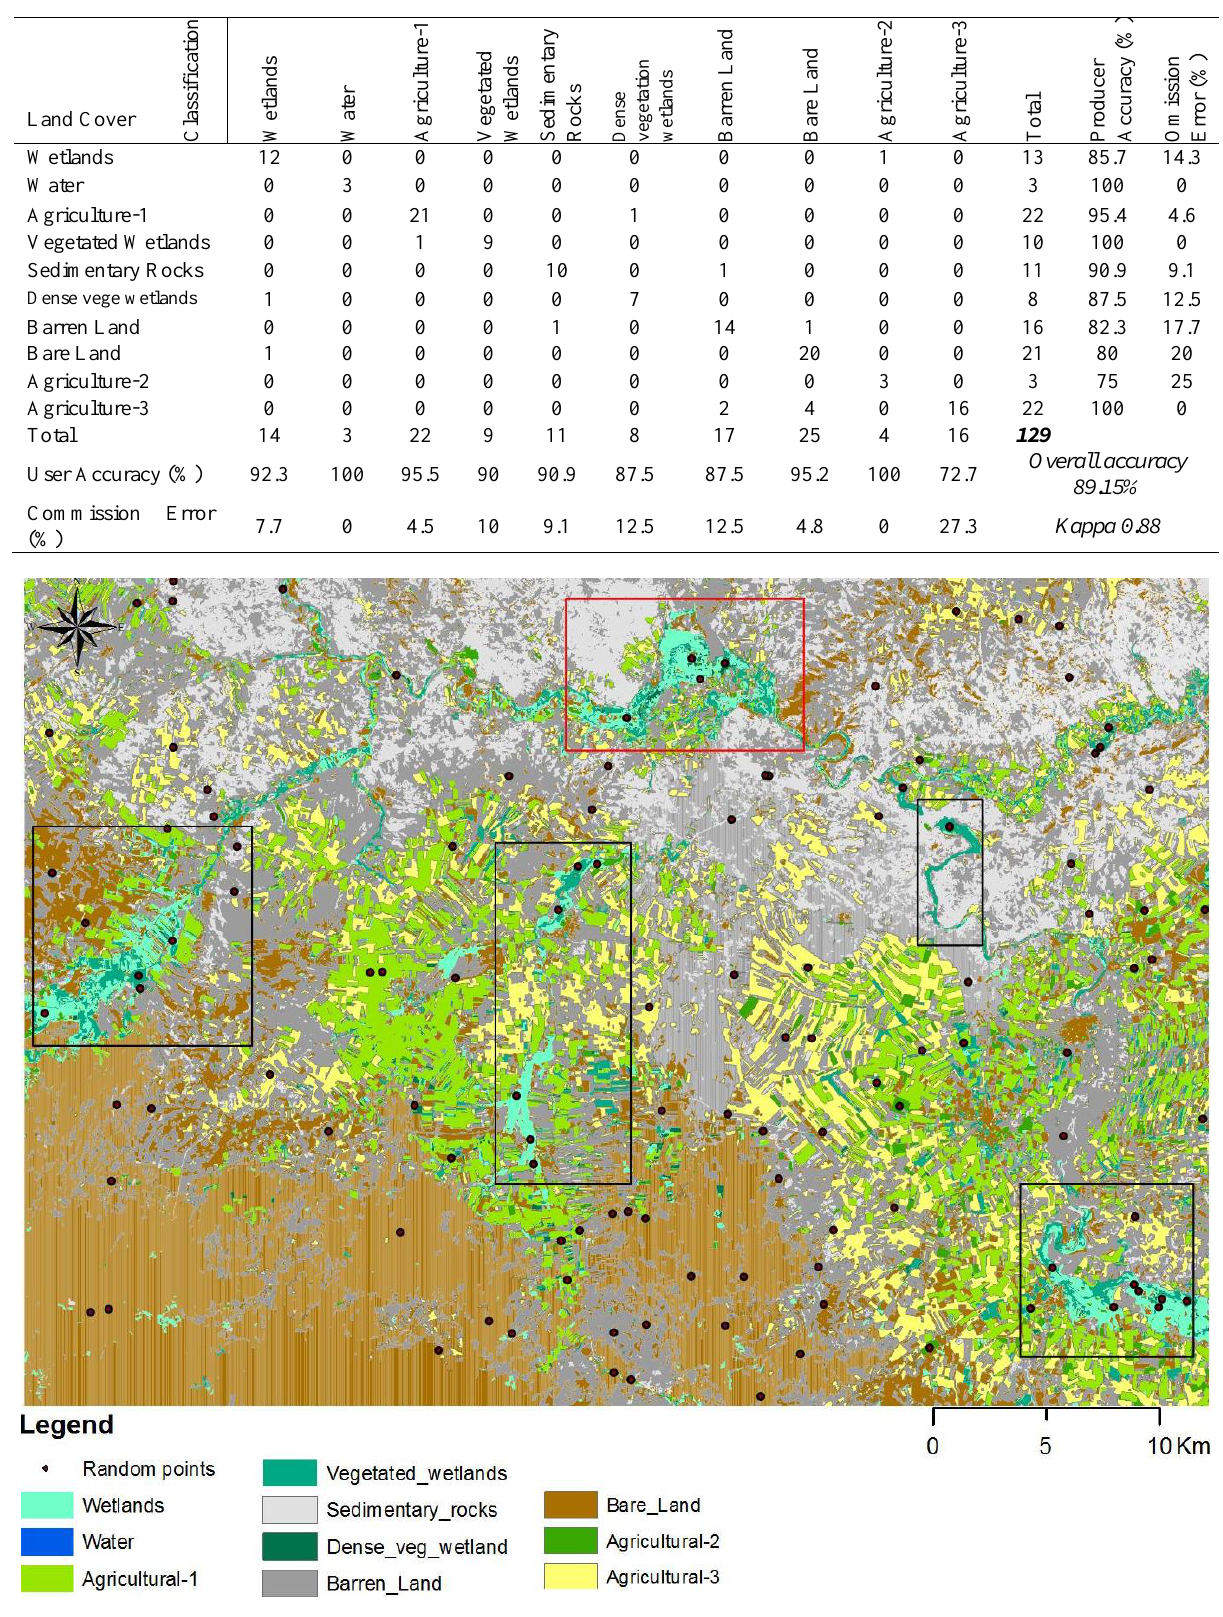
Figure 5. Classification results of the full study